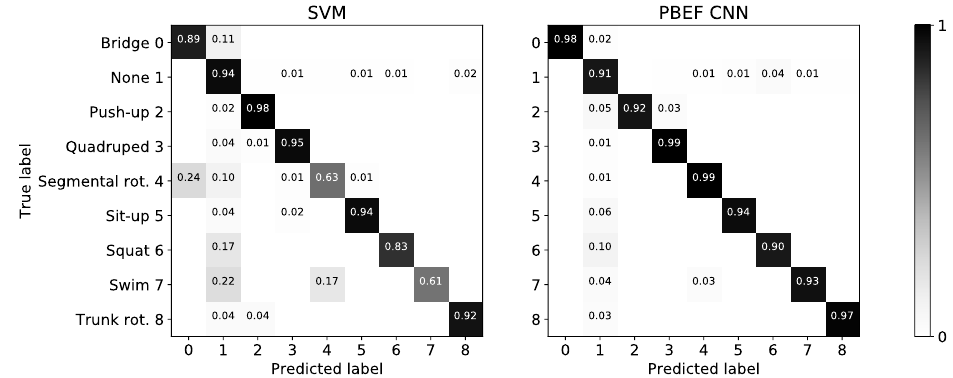
Figure A2. Confusion matrices of the models with the performance on the test sets for the multi-user evaluation is depicted